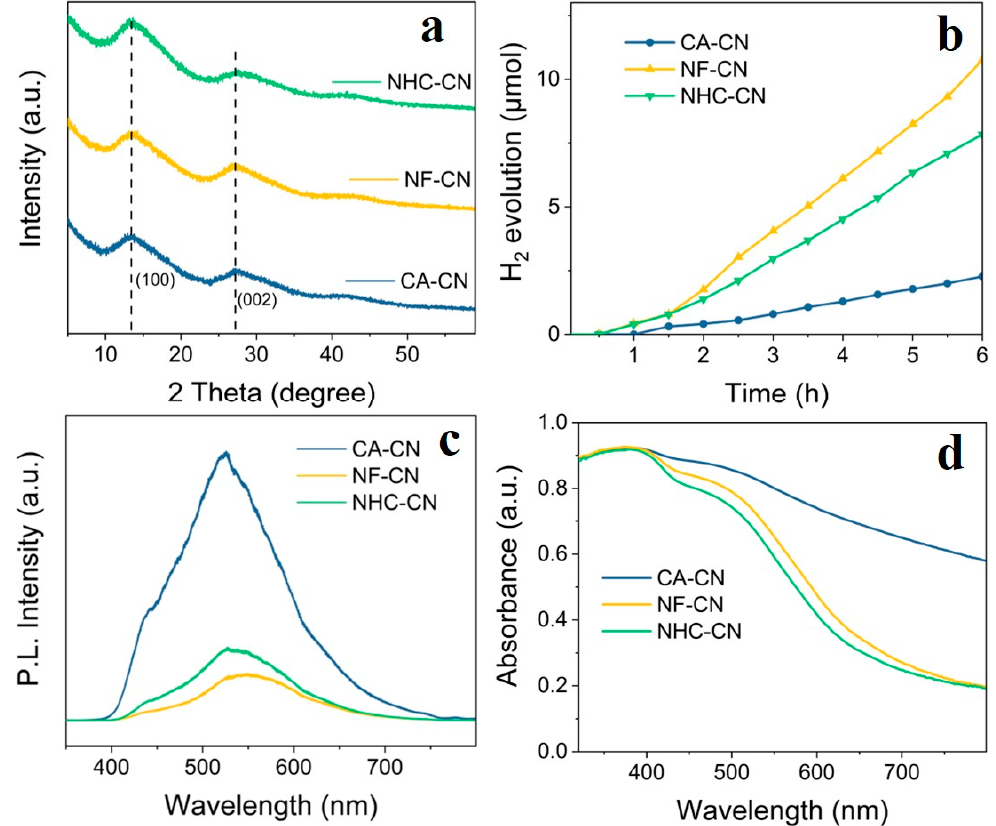
Figure 8. ( a ) XRD patterns of CA-CN, NF-CN, and NHC-CN. ( b ) Photocatalytic H 2 evolution of CA-CN, NF-CN, and NHC-CN. ( c ) PL spectra for CA-CN, NF-CN, and NHC-CN. ( d ) UV-vis diffuse reflectance spectra of CA-CN, NF-CN, and NHC-CN.